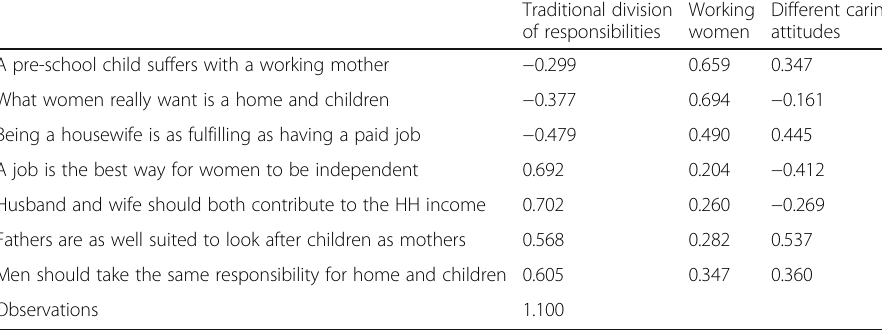
Table 2 Correlation between factors and responses to the questions in the World Value Survey (2008)